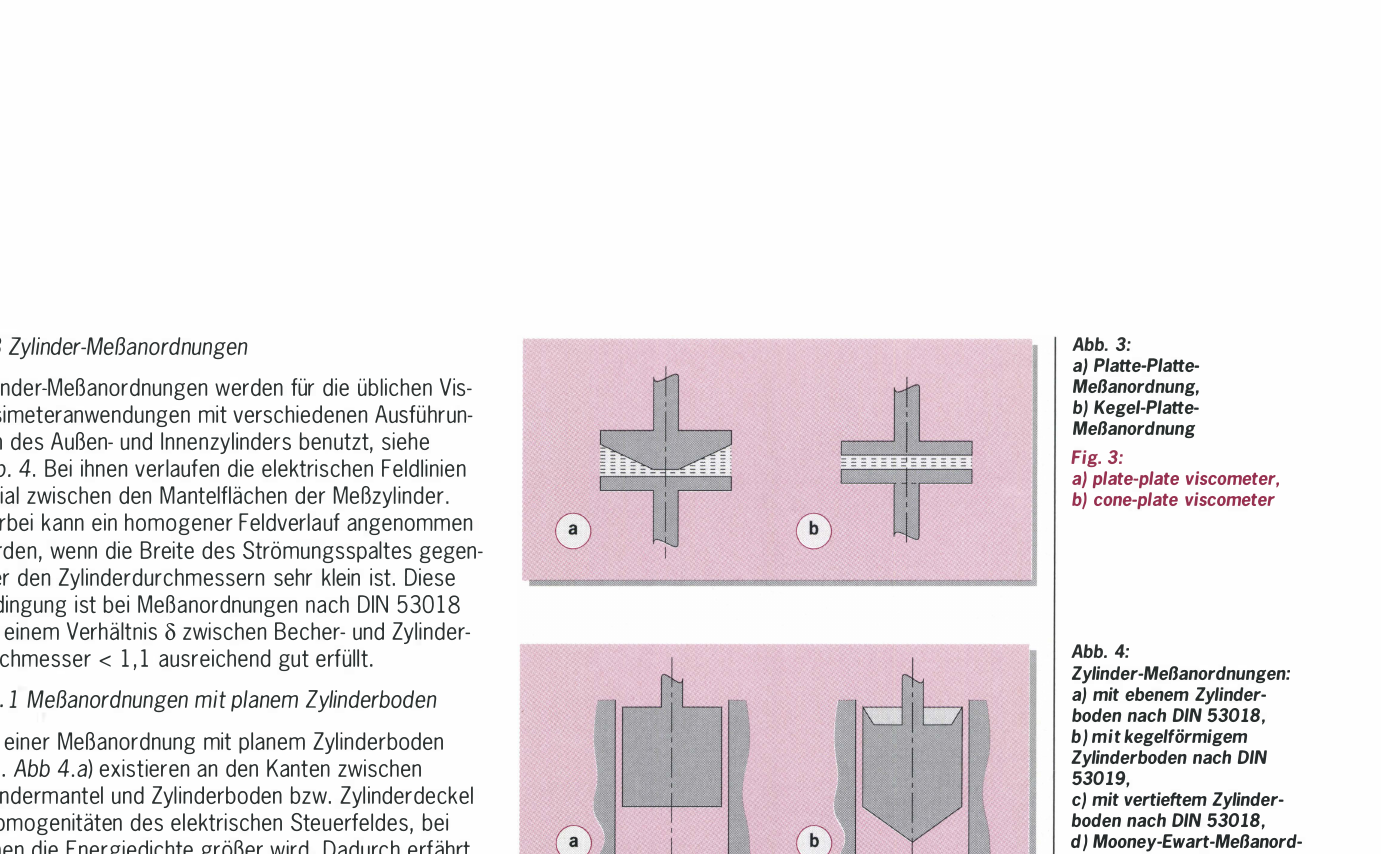
Fig. 4: Cylinder viscometers: a} with flat cylinder base according to DIN